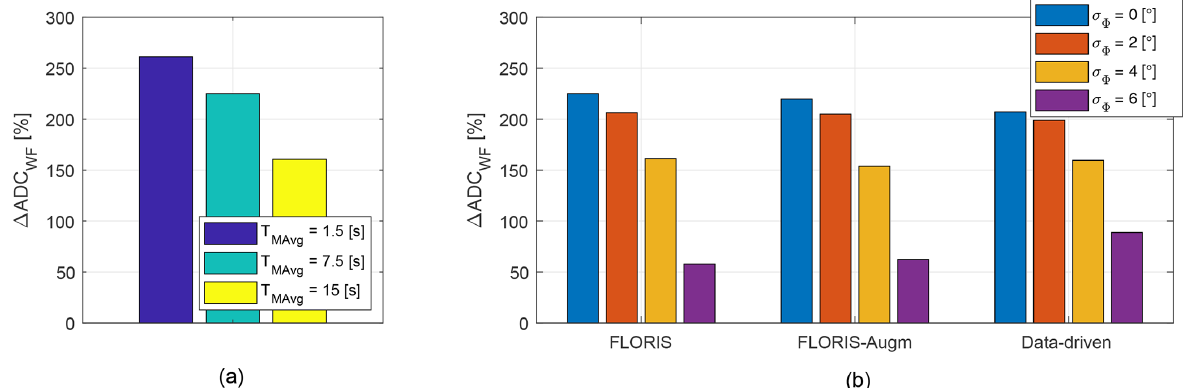
Figure 17. Change in wind farm yaw ADC with respect to the greedy case. (a) Effect of direction uncertainty: non-robust LUT for the baseline FLORIS model and varying T MAvg . (b) Effect of robustness and model fidelity: LUTs for the three models and increasing robustness, for a wind direction signal filtered with T MAvg = 7 . 5s.